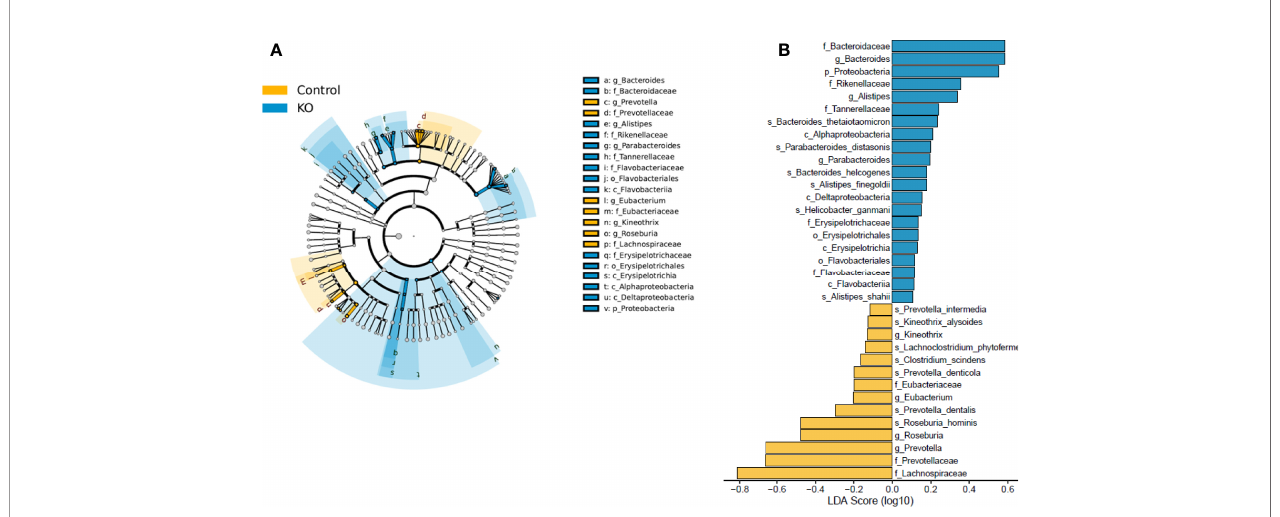
FIGURE 4 | LEfSe analysis of gut microbiota from NHE3 IEC-KO and control mice. Cladograms (A) shows the microbial clades with the greatest differences in abundance in microbiota from NHE3 IEC-KO and control mice. LDA scores (B) of microbial clades differing in abundance between NHE3 IEC-KO and control mice (with LDA score >0.1 and signi fi cance of P < 0.05, determined using Kruskal-Wallis test). N =